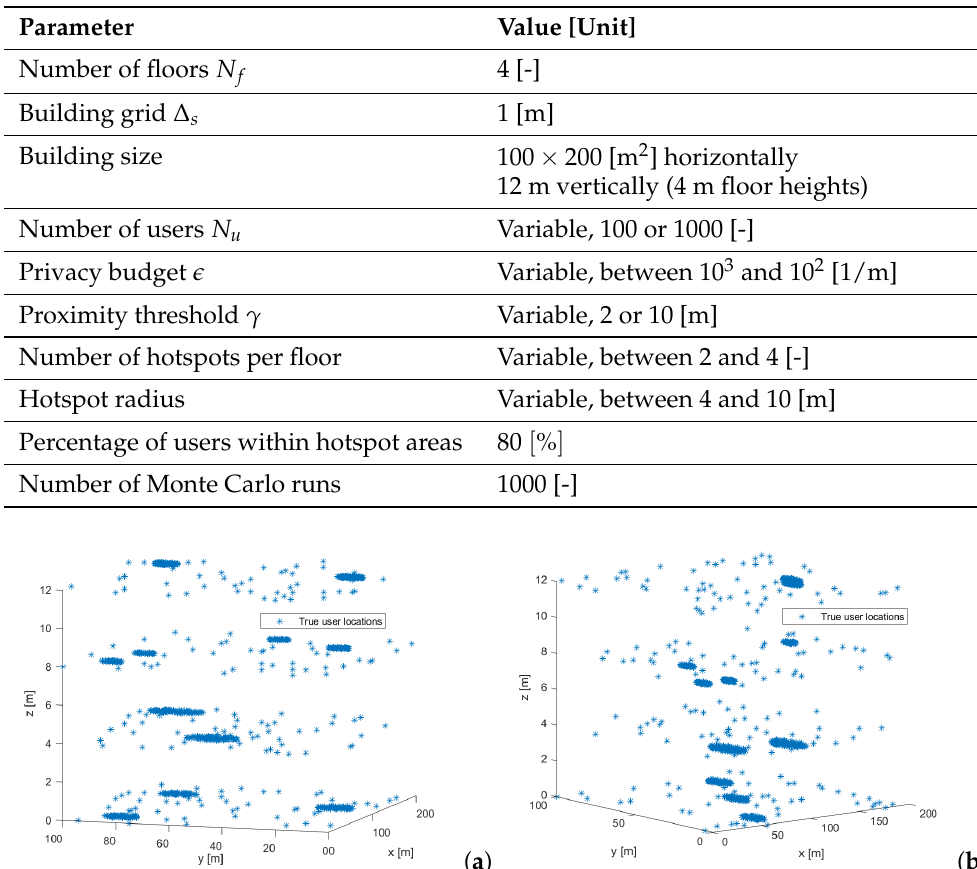
Figure 4. Two examples of users distribution within a 4-floor building during two Monte Carlo runs. ( a ) Monte Carlo run 1; ( b ) Monte Carlo run 2. In these runs, we allocated 80% of users are in hotspot areas and 20% of users are outside hotspot areas, uniformly distributed within the